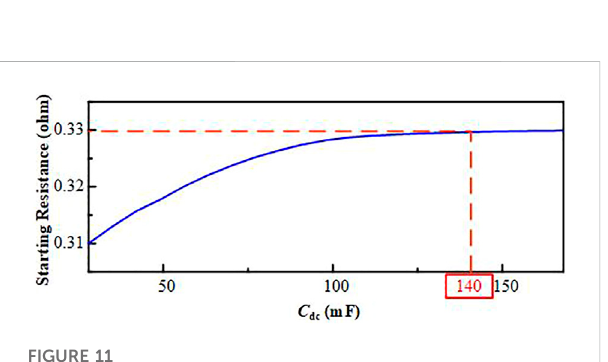
FIGURE 11 Relationship between C dc and charging